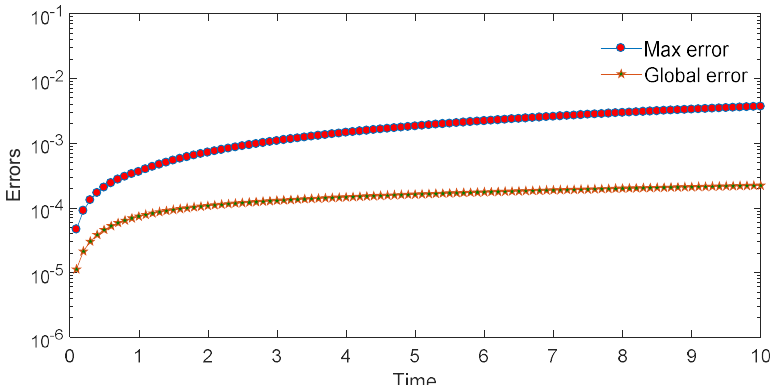
Figure 14. Two types of error curves of hydraulic head H from 0 t to 10 t .